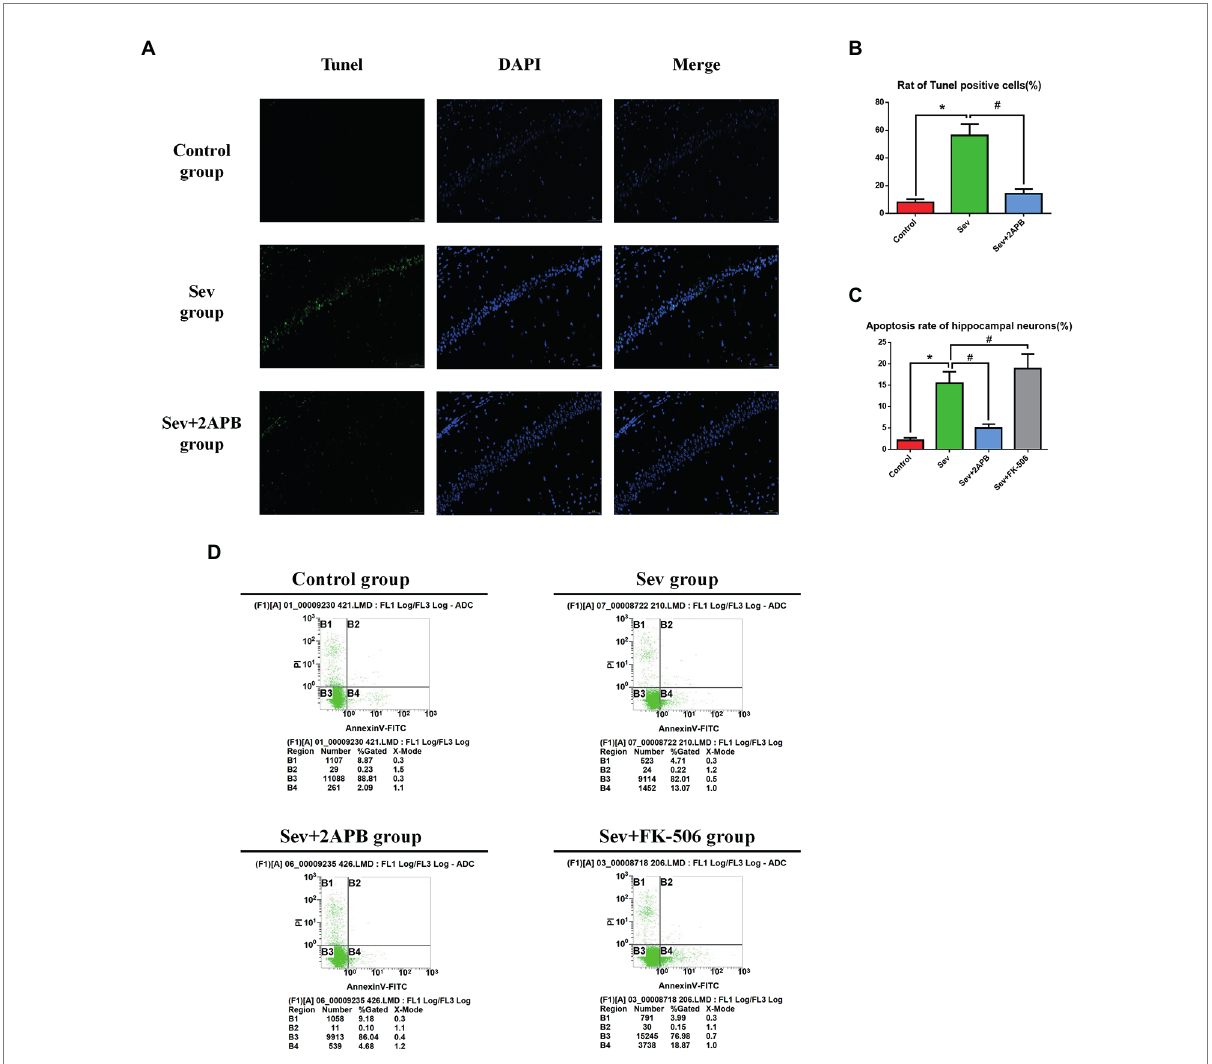
FIGURE 6 Sevoflurane promotes hippocampal neuroapoptosis in aged rats and isolated hippocampal neurons. (A) Representative images of TUNEL staining in the hippocampal CA1 region of aged rats (× 30) (green: Tunel positive cells; blue: DAPI, scale bar = 50 μ M). (B) Numbers of TUNEL-positive cells. (C) Apoptosis rate of hippocampal neurons. (D) Representative flow cytometry of hippocampal apoptosis. Data are presented as mean ± SD ( n = 5 in each group). Compared with Control group, * p < 0.05; compared with Sev group, # p <